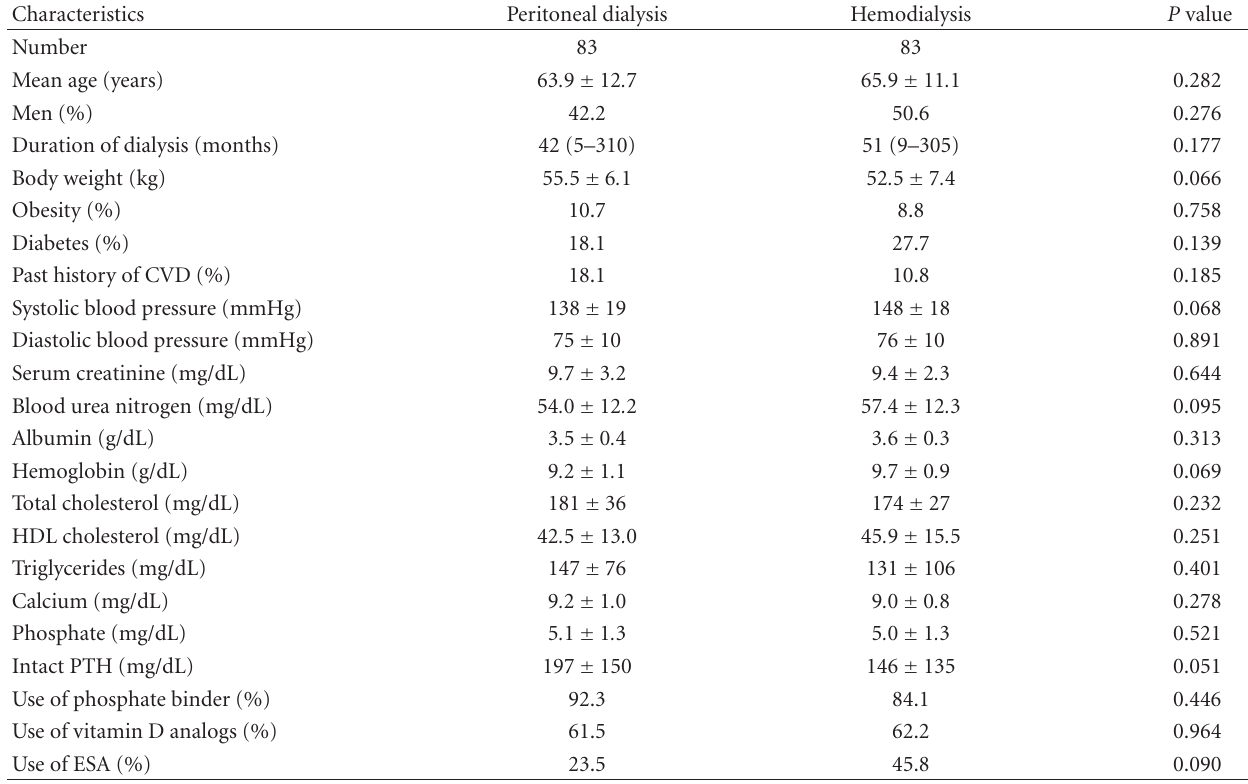
Table 1: Baseline characteristics of patients.